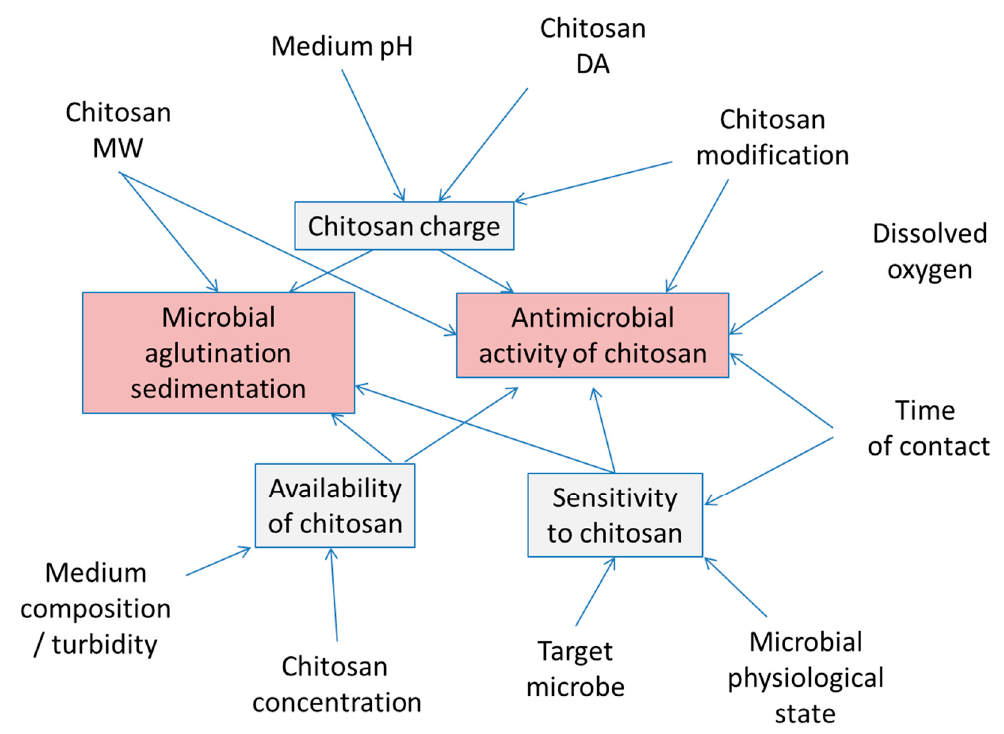
Figure 7. Parameters that modulate the antimicrobial activity of chitosan.